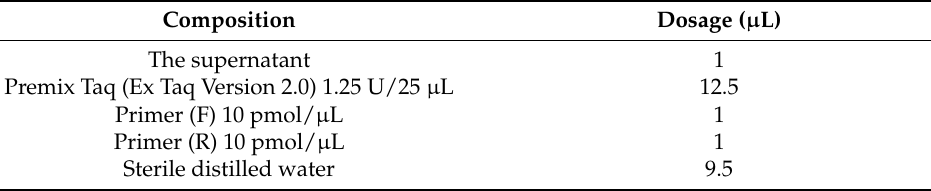
Table 1. Polymerase Chain Reaction (PCR) amplification system.